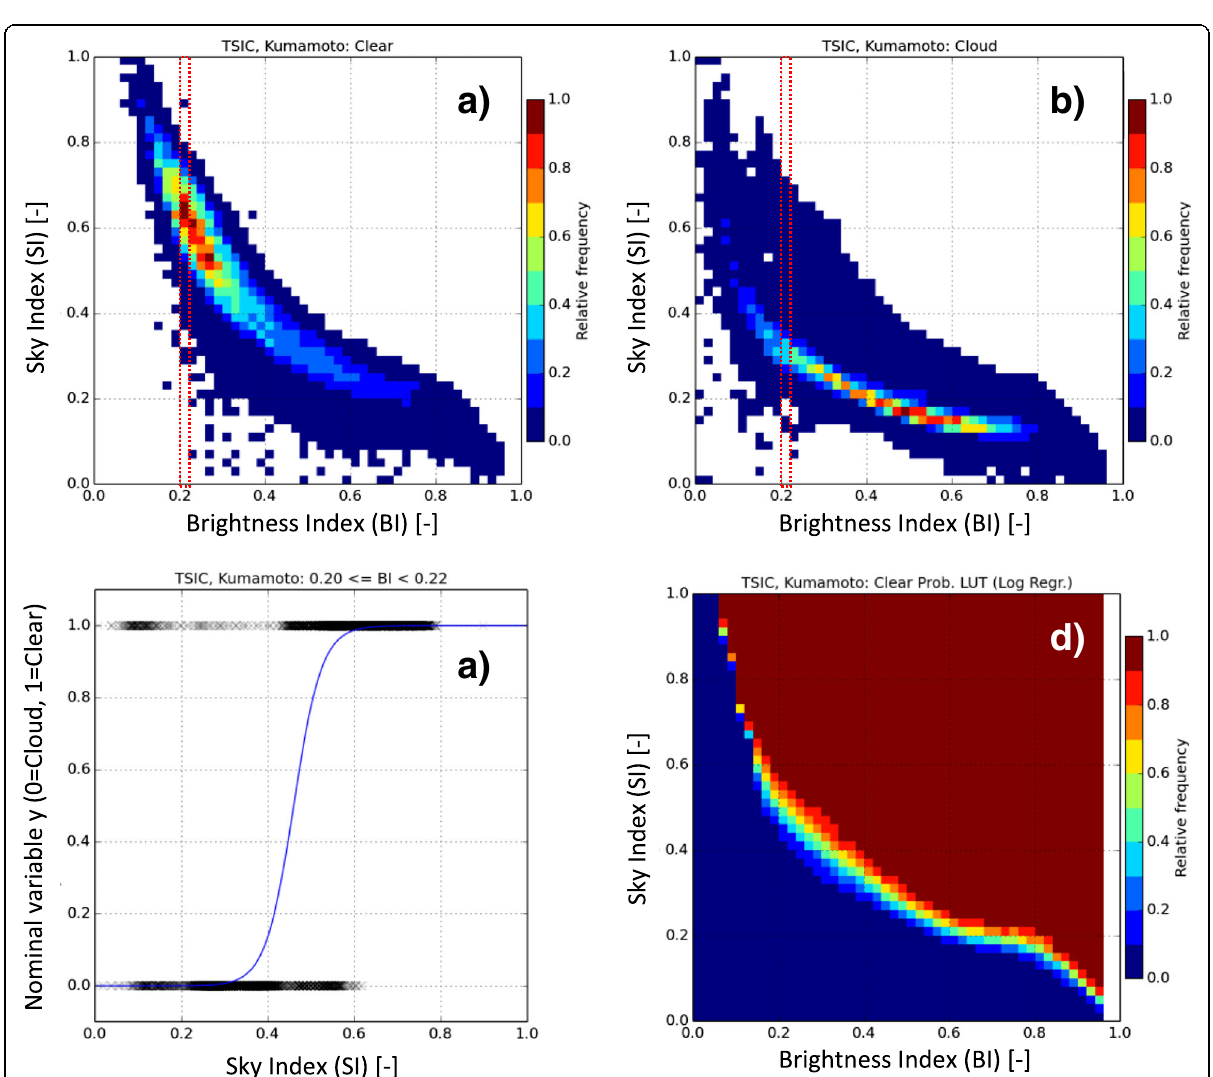
Fig. 9 Method of analysis for the logistic regression approach. a Two-dimensional histograms for clear training data and b cloudy training data. c An example logistic regression curve derived for the clear and cloudy cases within the bin class of BI shown in red dotted boxes in a , b , and d calculated clear probability in the BI-SI